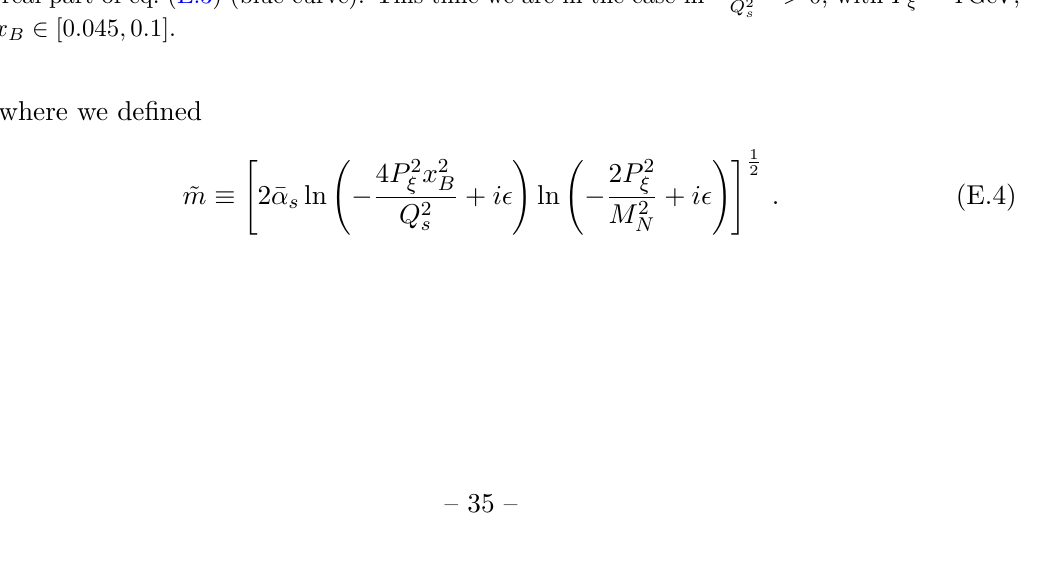
Figure 16 . Here, we compare the real part of eq. (8.6) (magenta-dashed curve) with its approxima- tion, real part of eq. (E.3) (blue curve). This time we are in the case ln 4 P and x B ∈ [0 . 045 , 0 . 1]